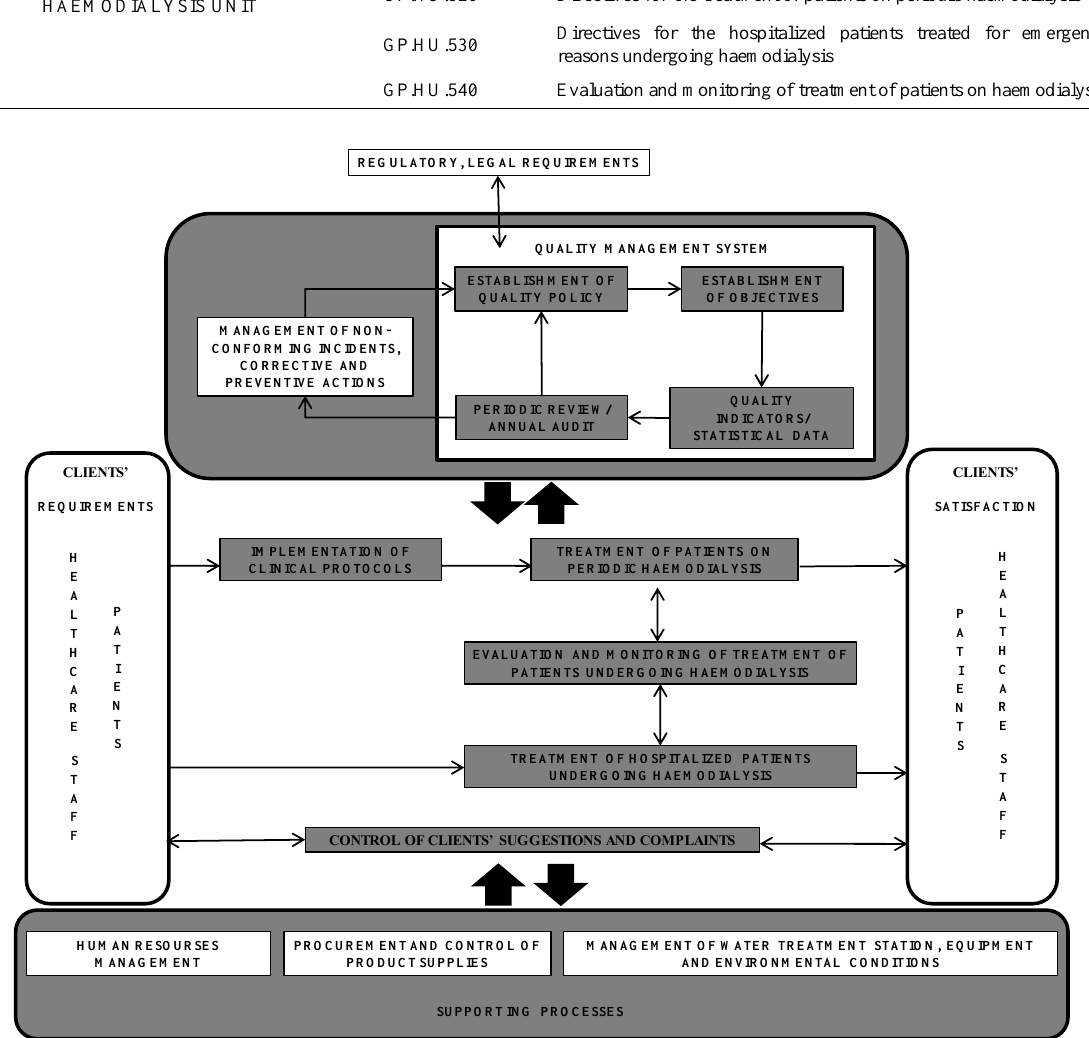
Figure 1. Process Interrelationship Chart that demonstrates the relation of General Procedures of the